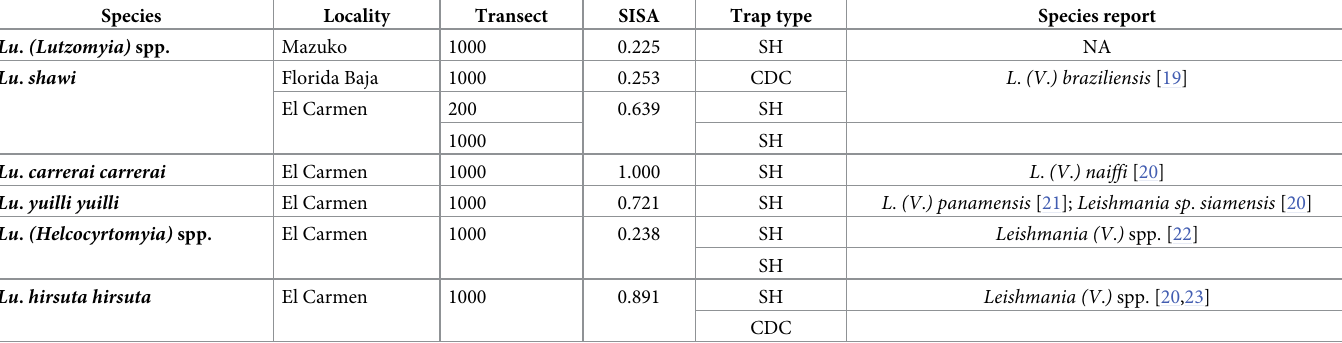
Table 1. Positive pools according to Lutzomyia species, study site and transect. The table shows that the majority of positive pools were collected in El Carmen, at the 1,000 m transect. The SISA index for each species per locality is also shown and the trap types as CDC Light traps (CDC) or Shannon trap (SH). The last column shows reports of Leishmania species naturally infecting these sand fly species [19–23].